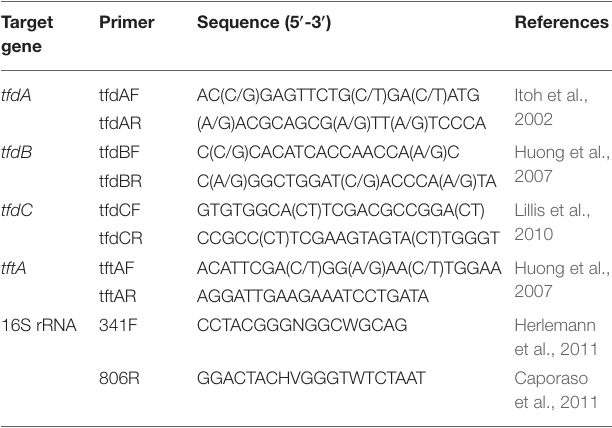
TABLE 1 | List of primers used for detection of genes involving in break-down of 2,4-D and 2,4,5-T and the V3-V4 region of bacterial 16S rRNA genes. Target